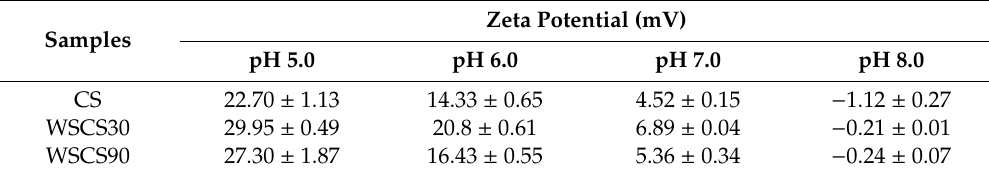
Table 3. Zeta potential of CS, WSCS30, and WSCS90 at different pHs. Samples